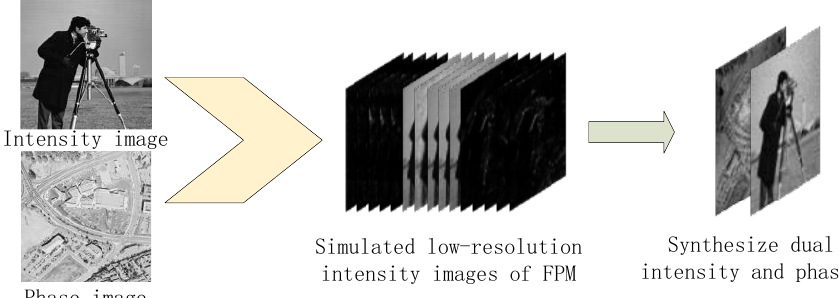
Figure 7. Process of simulating experimental data.